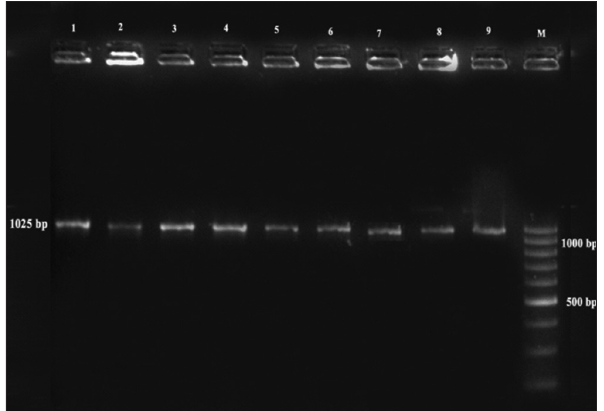
Figure-2: Polymerase chain reaction profile of Listeria innocua isolates from seafoods. Lane M: 100 bp ladder, lane 1-10: Isolates from seafoods.